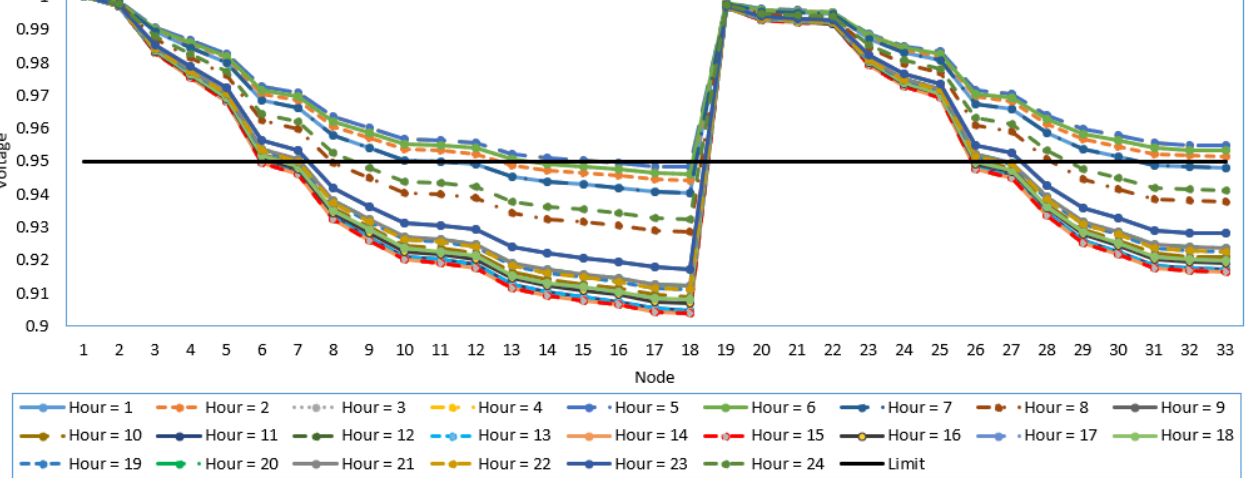
Figure 5. Hourly voltage profile for the first scenario for the IEEE 33-distribution system.